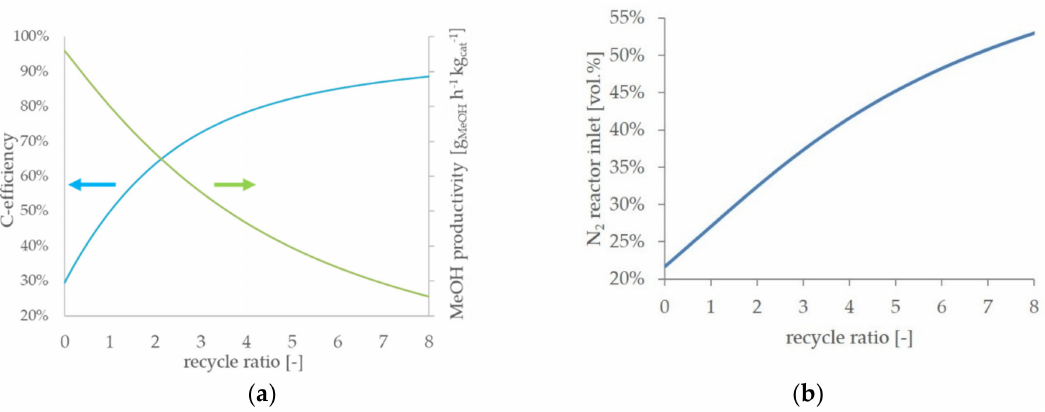
Figure 5. Carbon e ffi ciency and reactor productivity ( a ), and N 2 -amount at the reactor inlet ( b ) as a function of the recycle ratio (RR).